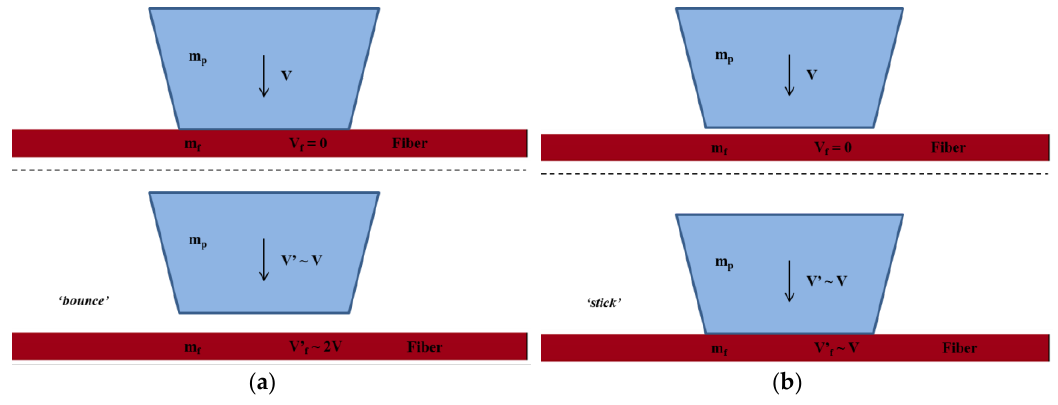
Figure 1. Perfectly ( a ) elastic collision and ( b ) inelastic collision.